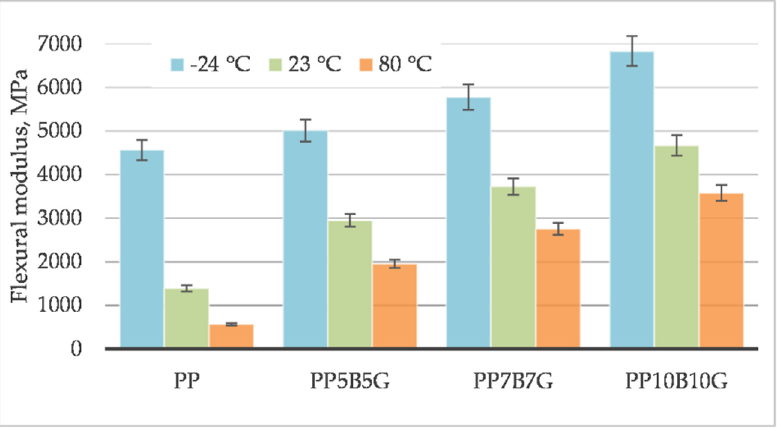
Figure 13. Flexural strength of basalt/glass polypropylene composites at − 24 ◦ C, 23 ◦ C and 80 ◦ C.